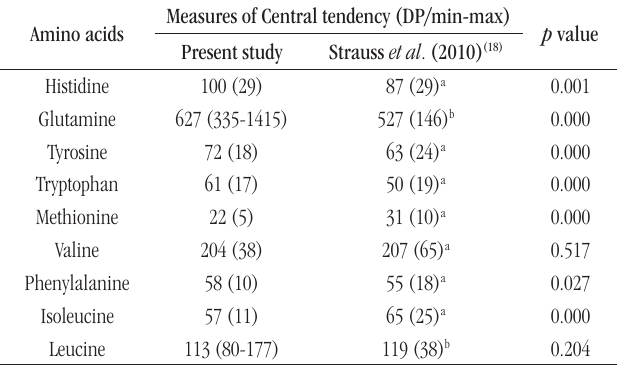
taBLE 7 − Comparison of amino acids values